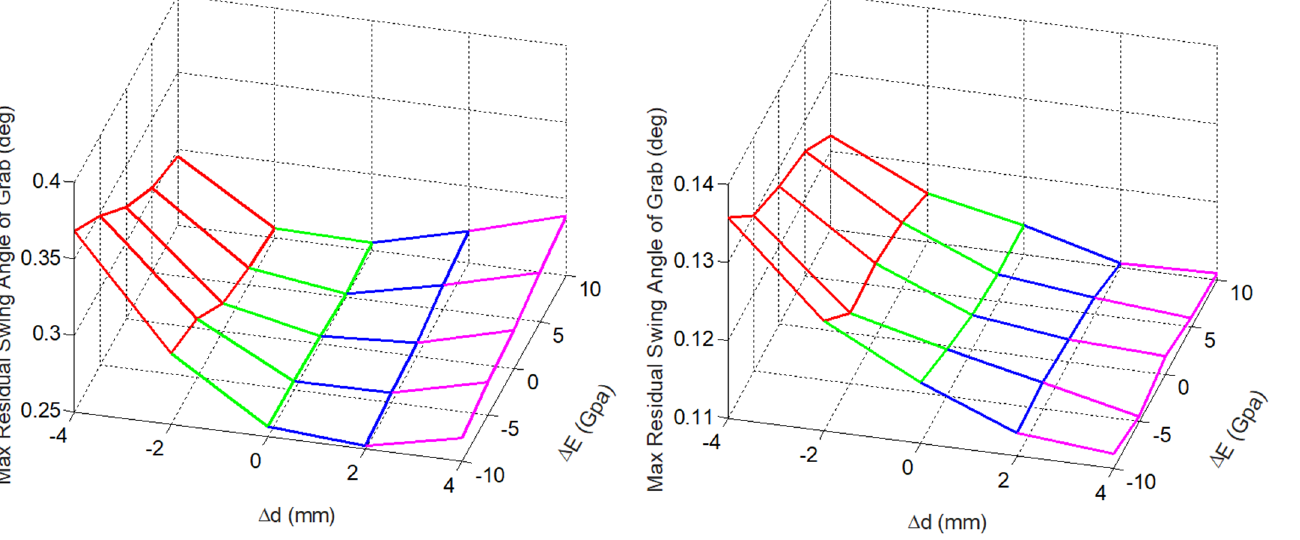
Fig. 11. Curves of maximum residual swing angle varied with the deviations of the wire rope diameter and the elastic modulus during empty load